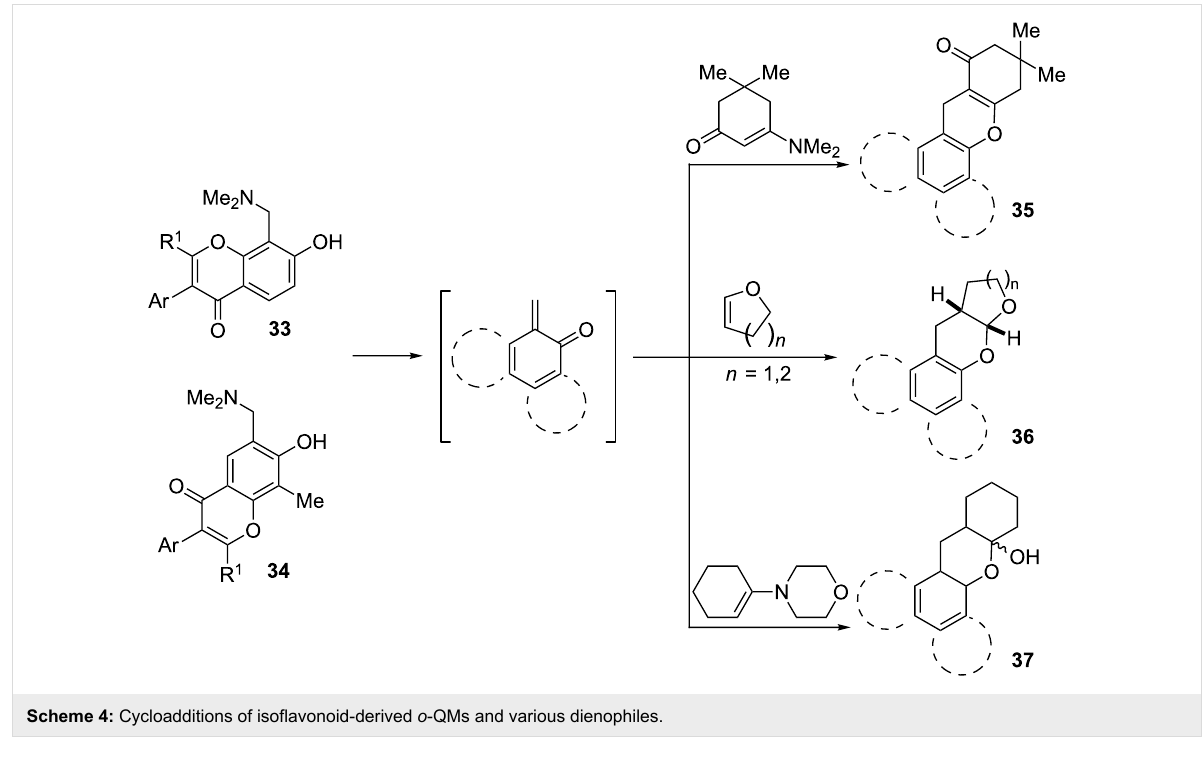
Table 4: Dimerization of o